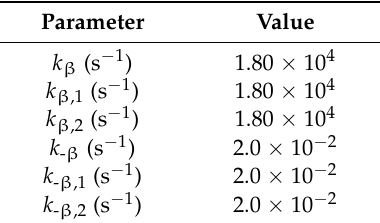
Table 5. Final estimated values of rate coefficients for CPDB-mediated polymerization of TBDMSMA in toluene at 70 ◦